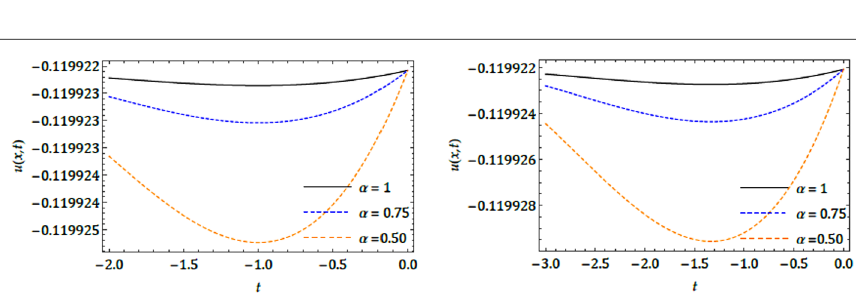
Figure 15 Nature of v ( x , t ) with distinct (cid:2) for Example 6.2 at (cid:13) = 0.1, c = 10, n = 3, α = 1 and x = 1